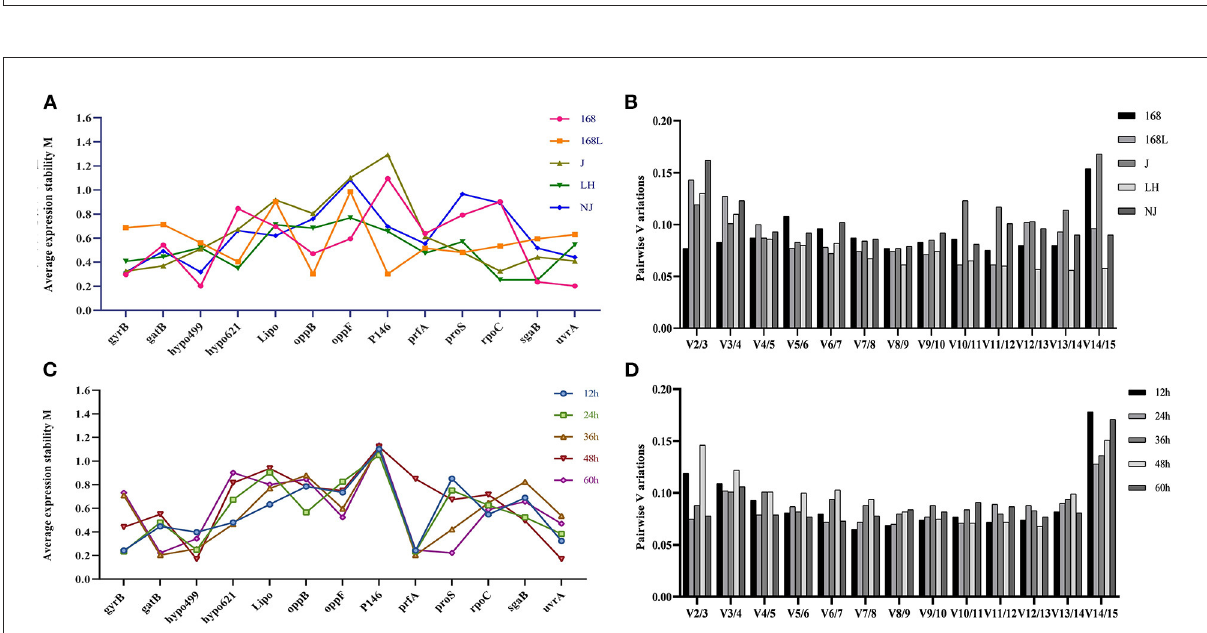
FIGURE2 Ct value distribution of candidate reference genes in all samples by RT-qPCR. Boxes represent the mean Ct value and bars depict the mean ± standard deviation.